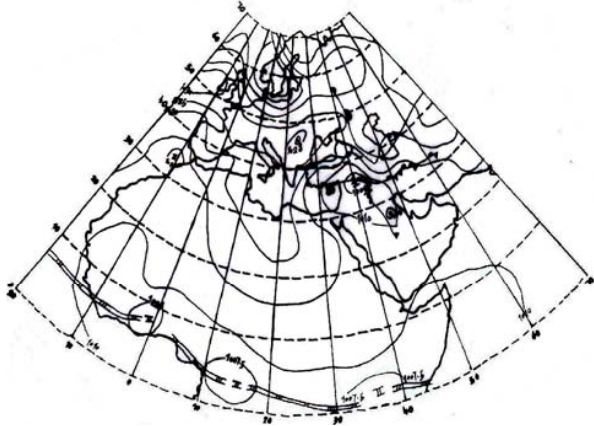
Fig. 11 The pattern of the geopotential heights and the LA center at 500 hPa before the heavy rainfalls (Type III: 15 February 1988)